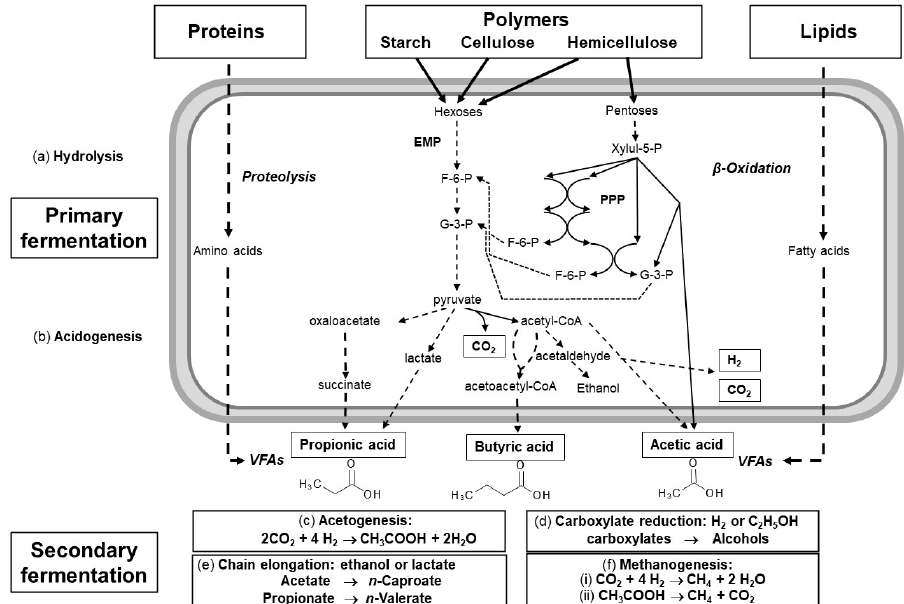
Figure 1. The biological process is initiated by ( a ) hydrolysis of polymers to monomers and oligomers; ( b ) these monomers are then converted by mixed cultures via acidogenesis to pyruvate that leads to the production of intermediate carboxylates, ethanol, lactate, hydrogen and carbon dioxide. ( c ) These products are converted by mixed cultures via various reactions, including autotrophic homoacetogenesis of carbon dioxide and hydrogen to more acetate; ( d ) reduction of the carboxylates with hydrogen or ethanol to produce various alcohols, e.g., propionate to propanol; ( e ) chain elongation of the VFA to medium-chain fatty acids by reverse- β -oxidation with ethanol or lactate to produce medium-chain fatty acids; and ( f ) methanogenesis with either ( i ) hydrogenotrophic methanogens that produce methane and water from carbon dioxide and hydrogen; or ( ii ) acetoclastic methanogen- esis where acetate is converted to methane and carbon dioxide (adapted from Agler et al. [49] and De Groof et al.